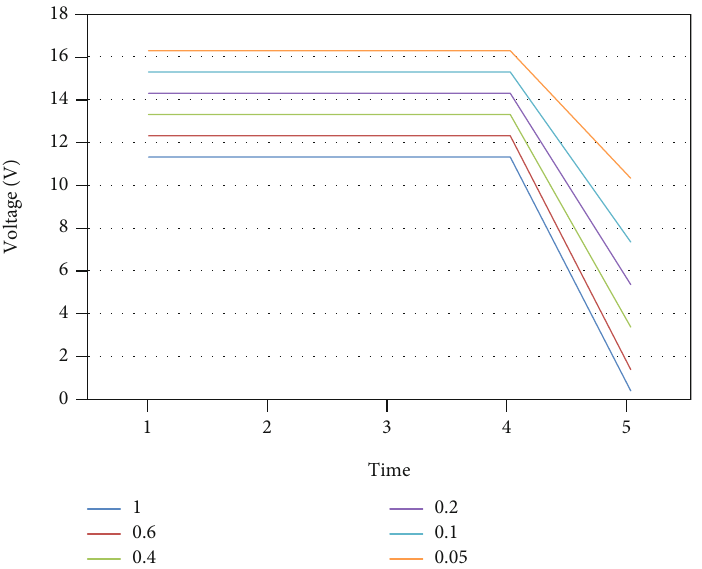
Figure 4: Characteristics of battery discharge.